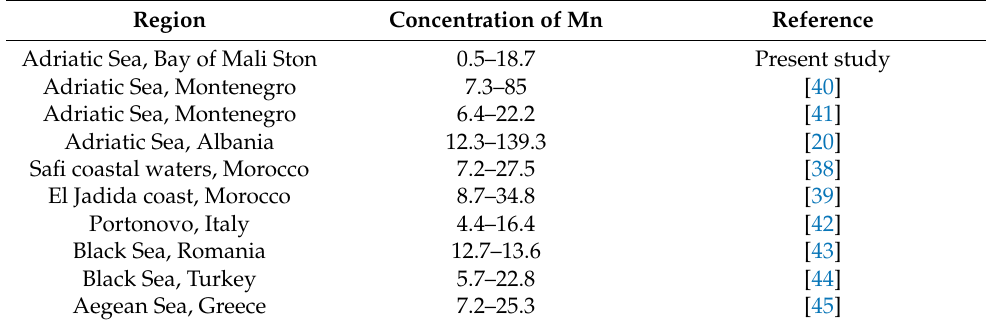
Table 3. Comparison of Mn concentrations in Mytilus galloprovincialis obtained in this study with literature data from other regions all over the world (mg kg − 1 d